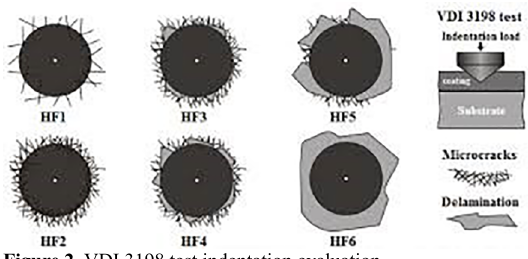
Figure 2. VDI 3198 test indentation